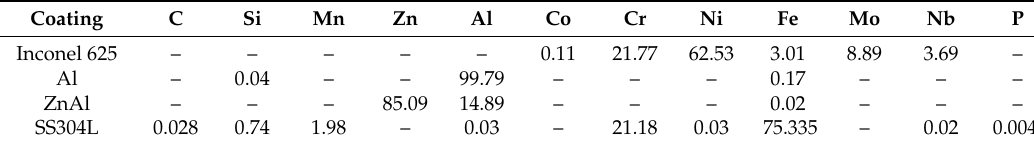
Table 1. Chemical composition of the substrate and thermal spray materials. Unit: wt %.